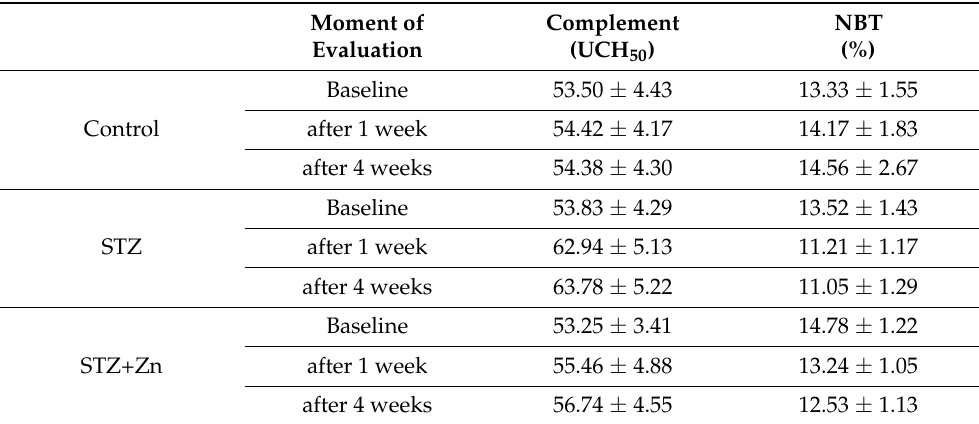
Table 7. The effect of Zn on the activity of serum complement activity and the NBT test values in diabetic rats. (NBT—nitroblue tetrazolium, UCH50—50% haemolytic complement activity). The values are presented as mean value ± S.D. for five animals in a group.